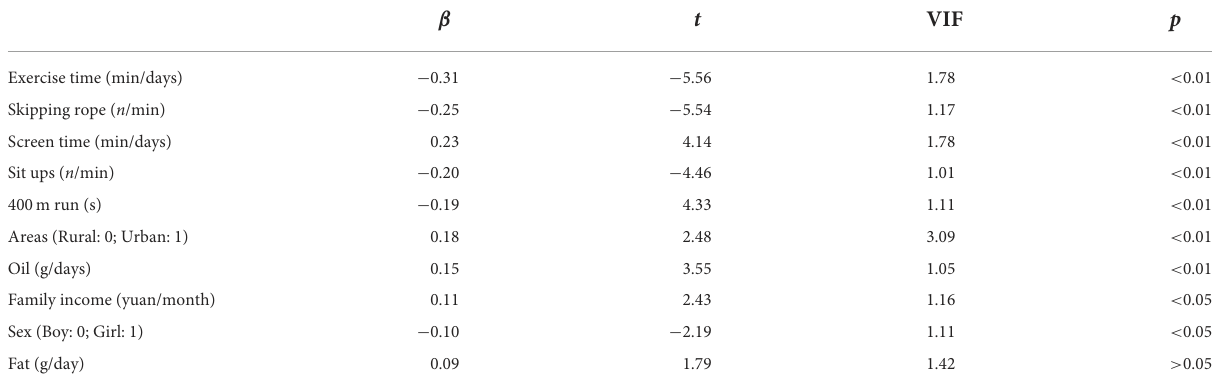
TABLE 5 Factors that contributed to the tendency toward obesity †